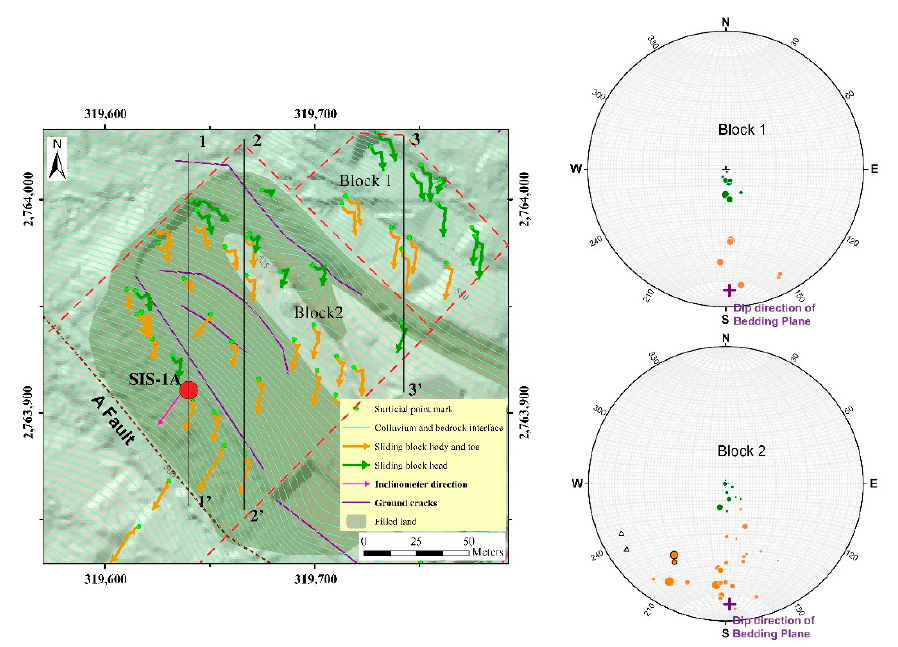
Figure 14. Groups of surficial displacement at the Huafan University campus: ( a ) horizontal dis- placement tracks, revealed by surficial monitoring within the measurement period and the group’s distribution. The displacement vectors represent the movements from the beginning to the end dur- ing the measurement period. ( b ) The geometry of displacements, i.e., the displacement vectors pre- sented in a stereonet. The diameter scale shows magnitudes of displacement, and the solid purple cross represents the dip direction of the bedding plane in Zone 2.